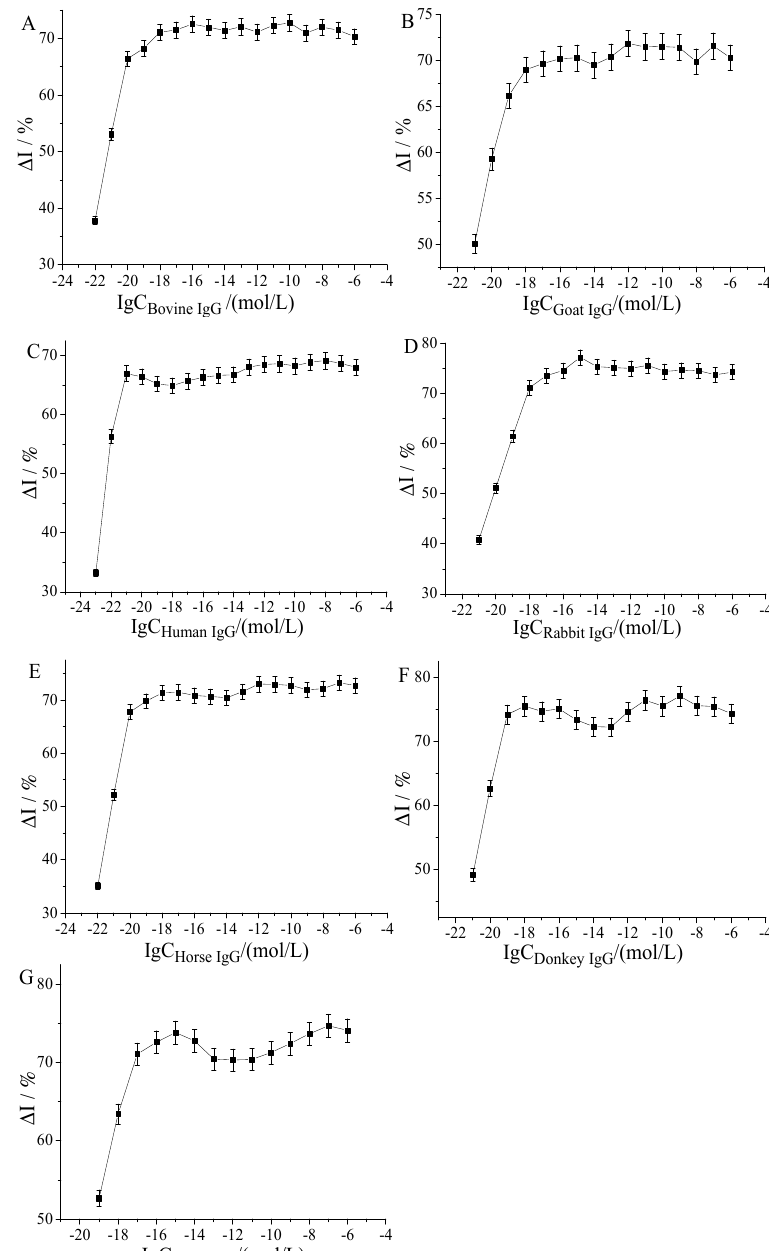
Figure 7. The current change rate of seven IgGs in the detection range. Bovine IgG ( A ), goat IgG ( B ), human IgG ( C ), rabbit IgG ( D ), horse IgG ( E ), donkey IgG ( F ), and quail IgY ( G ). All data show the mean ± SD of three